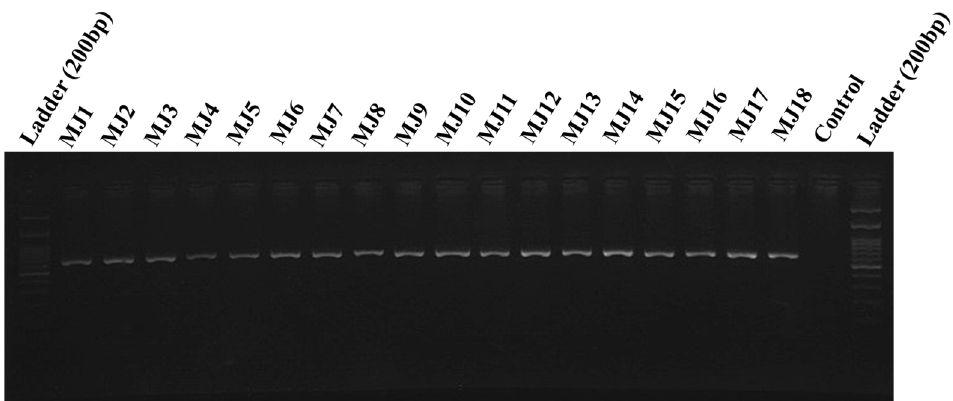
Figure 2. A 670bp species-specific band obtained in Meloidogyne javanica populations from 11 different provinces of Iran (for specifications of codes, see Table 1). Table 3. Average of the morphometrics of females, second-stage juveniles (J2s) and males of the populations of Meloidogyne javanica studied in this research (Measurements are in µm).